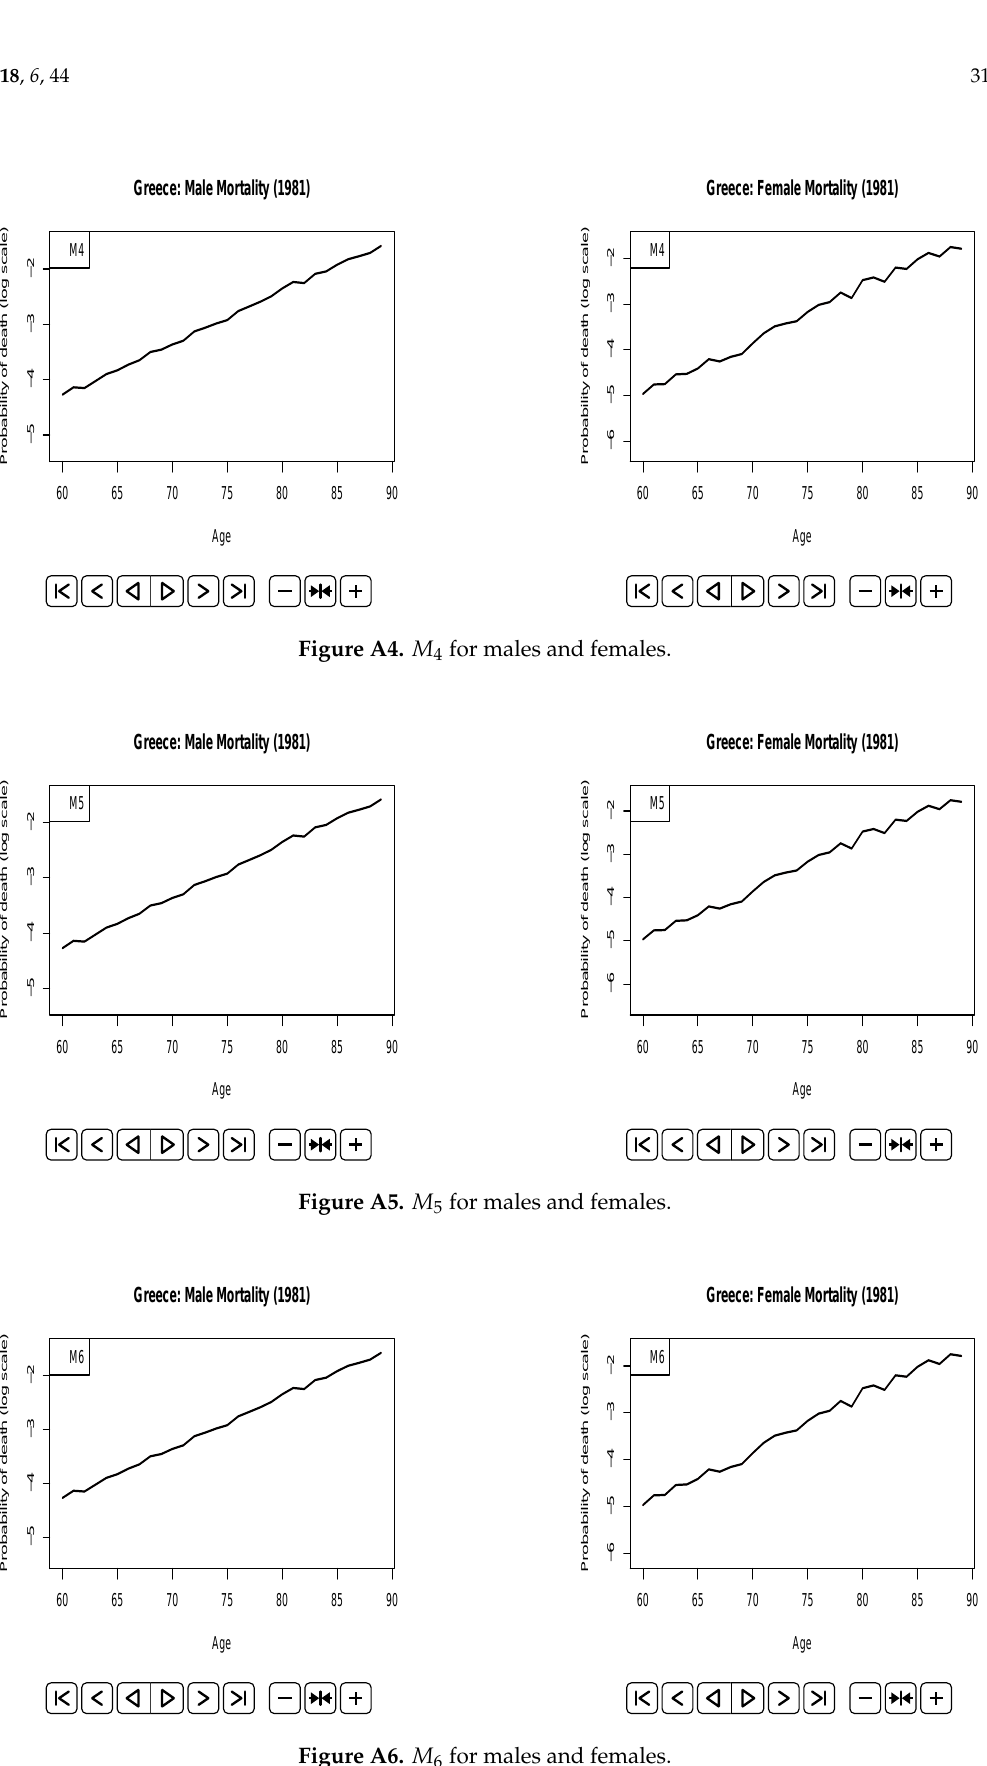
Figure A6. M 6 for males and